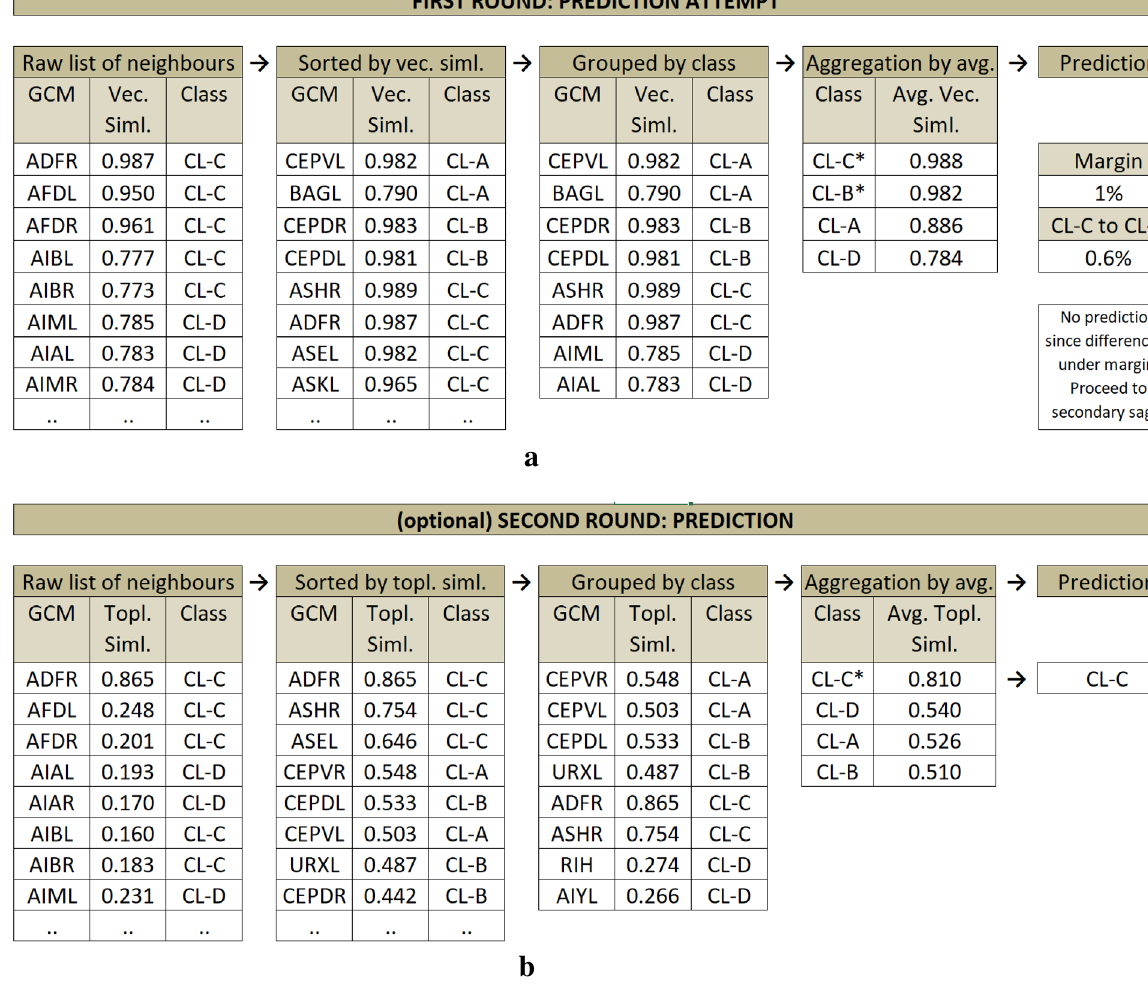
Figure 6. ( a ) Prediction Phase 1 sample diagram on C. Elegans dataset. İllustrating the prediction attempt of the test node ADFL (not displayed in the diagram). Raw list of neighbors of ADFL listed, sorted by vectorial similarity, grouped by class, and finally similarities are aggregated by class. A prediction is not made since the top two highest averaged classes have very close scores (under margin). ( b ) Prediction Phase 2 sample diagram on C. Elegans dataset. Illustrating the prediction of the test node ADFL (not displayed in the diagram). This time, the prediction is made based on topological similarity in the same fashion with the first round. This time, without seeking a distinctive margin, the top (highest topological similarity average) class is assigned as the